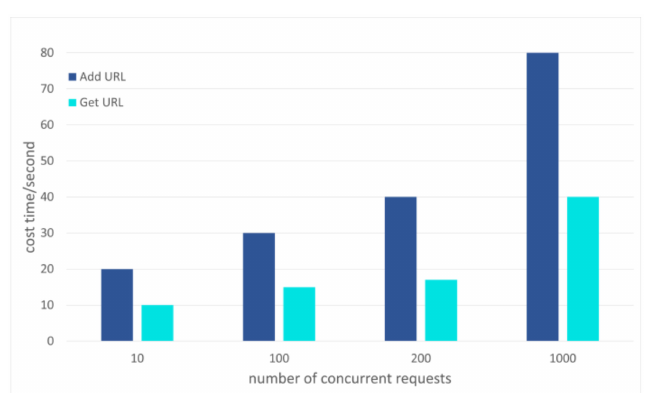
Figure 21. Time cost of Policy Contract (PC).